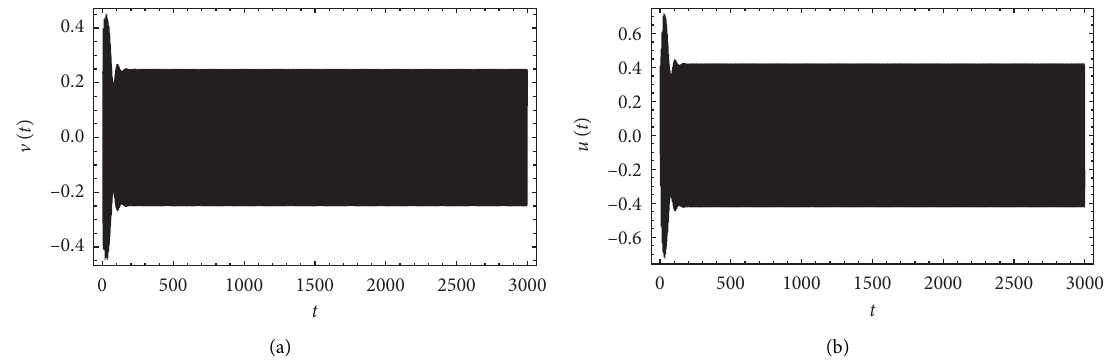
Figure 14: Time history for the controlled system when τ v ( 0 ) � 0 . 748 ,u ( 0 ) � 1 . 27 , _ v ( 0 ) � 0 . 1 , and _ u ( 0 ) � 0 . 01: (a) the main system; (b) the controller.